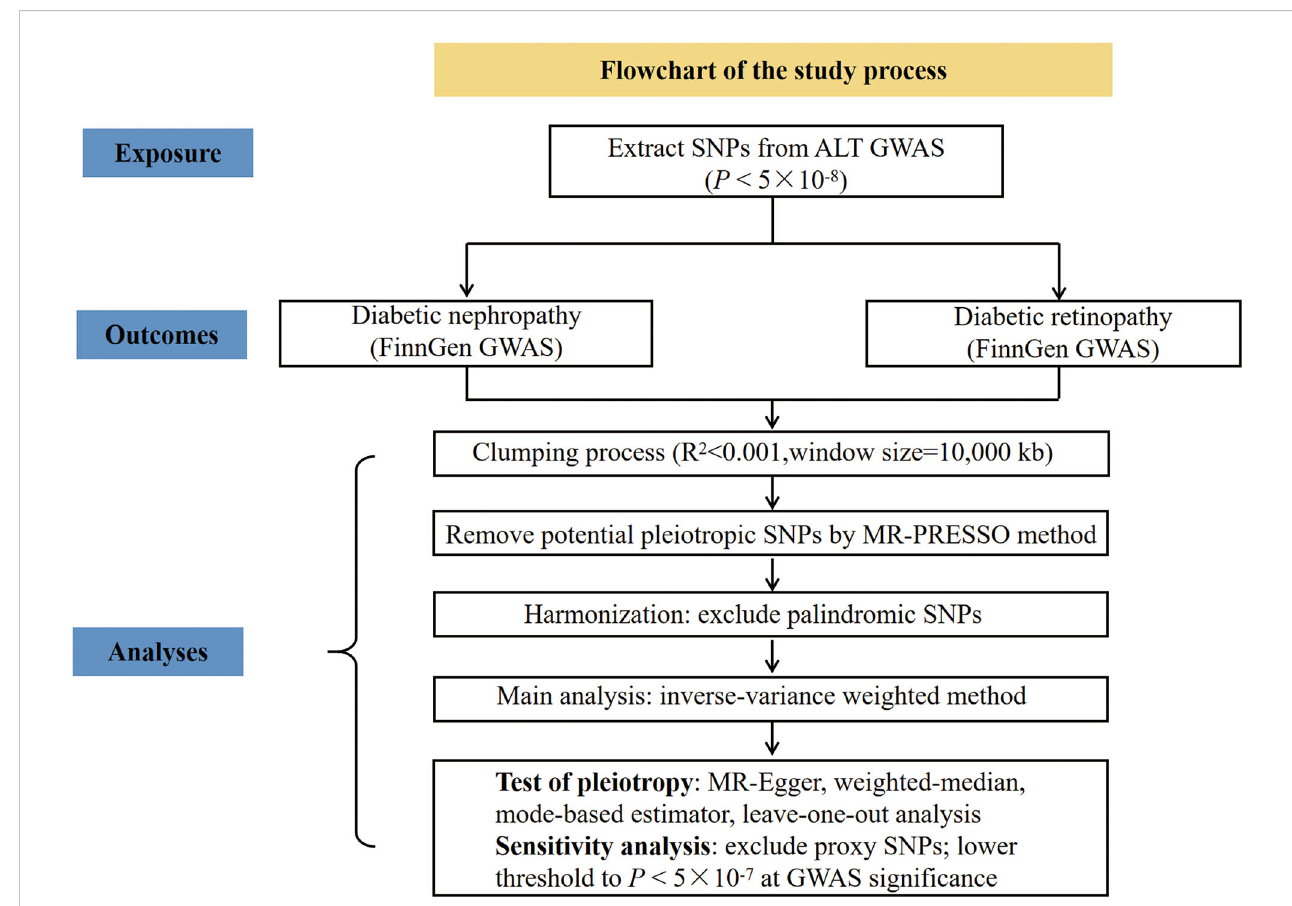
FIGURE 1 Flowchart of the study